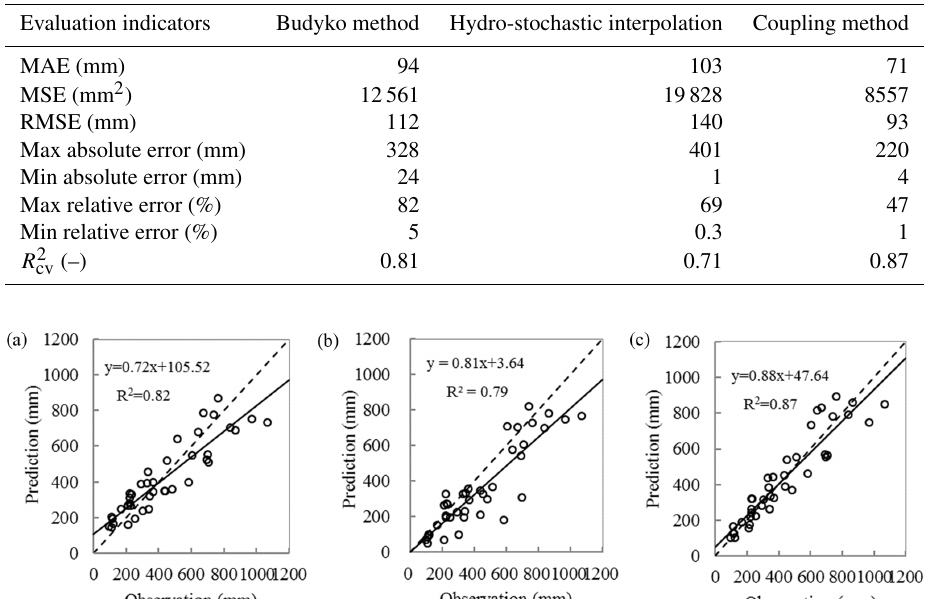
Figure 6. Cross-validation of the predicted runoff vs. the observation by (a) the Budyko method, (b) hydro-stochastic interpolation, and (c) our coupled method. The dashed line is